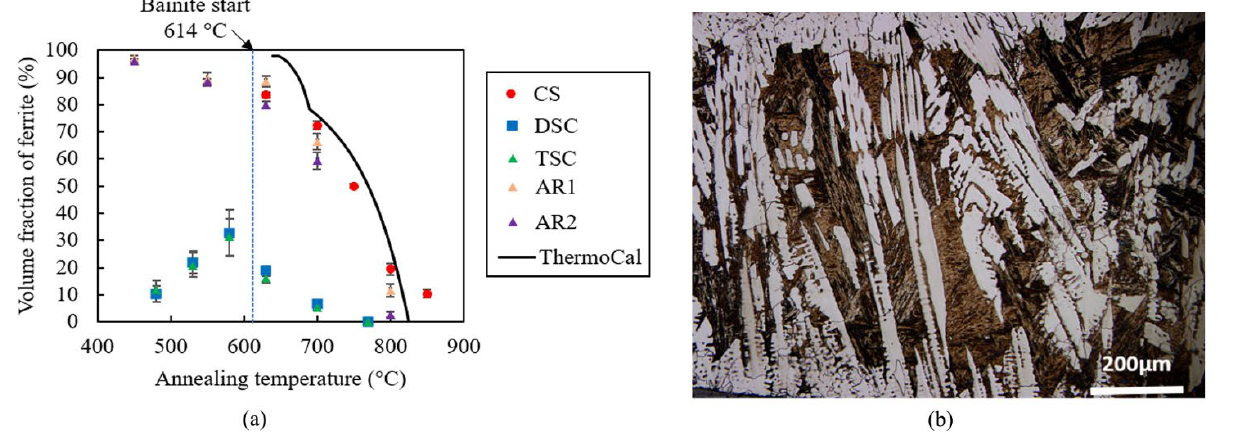
Figure 12. ( a ) Effect of annealing temperature on polygonal ferrite formation. Heat treatment time is 300 s for primary treatment and 600 s for secondary treatments; ( b ) Microstructure of DSC specimen after inter-critical annealing at 630 °C for 10,000 s.